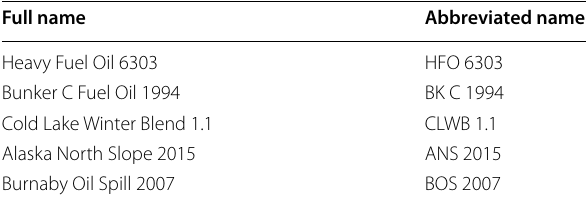
Table 1 Five crude oils used for reporting the microcosm weathering experiment results with full and abbreviated